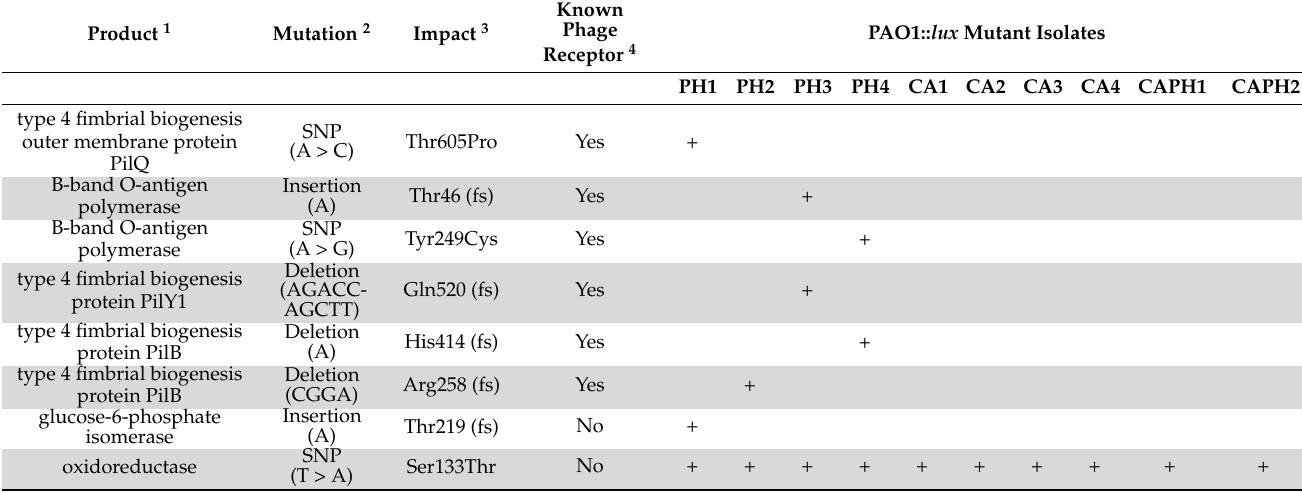
Table 5. Summary of observed small variant (SNPs and short indels) with respect to progenitor strain PAO1:: lux observed in recovered mouse mutant strains and whether the mutation impacts a known phage receptor.